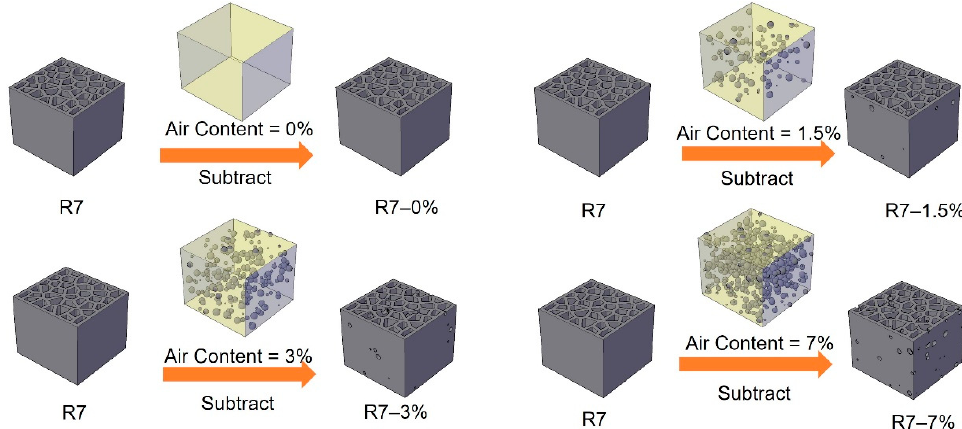
Figure 13. Schematics of generating cellular specimens with virtual air void defect structure.